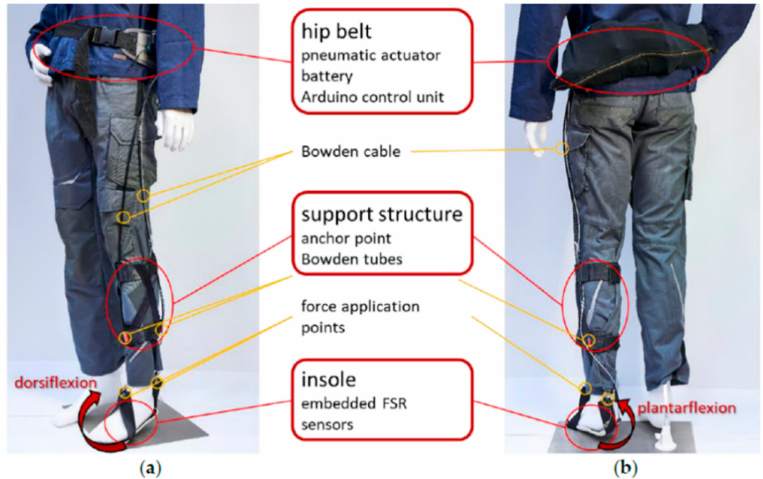
Figure 12. ( a ) Front and ( b ) rear view of the soft ankle exosuit [91] (Open